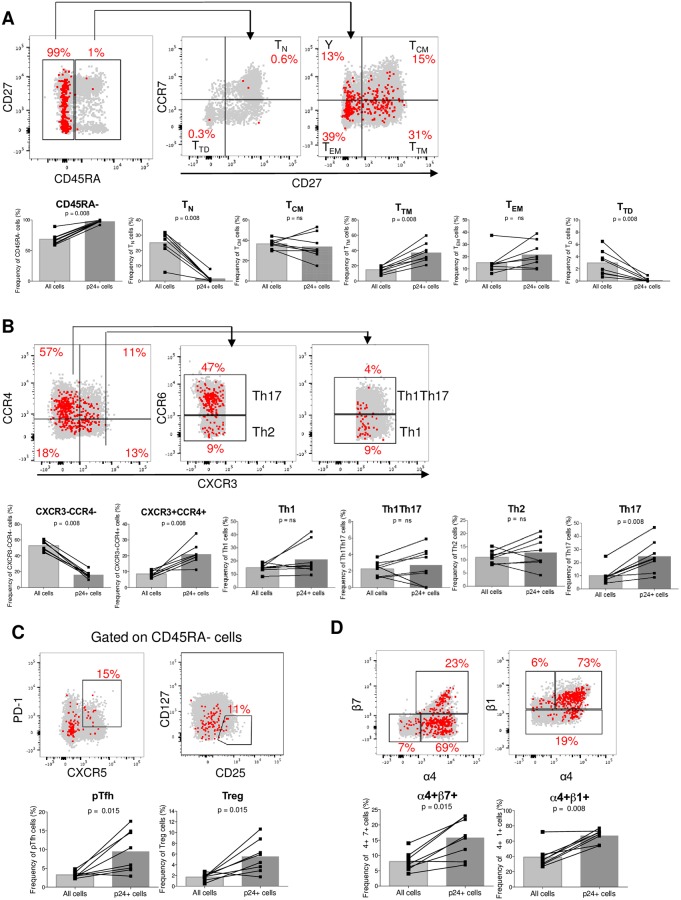
p24-producing cells from untreated individuals are enriched in various cell subsets.Representative dot plots showing the phenotype of p24+ cells (represented as red dots) overlaid onto all cells (in grey) after an 18h-resting. The contribution of a given subset to the pool of all cells and to the pool of infected cells (p24+) are compared in samples from n = 8 untreated individuals (same as in Fig 4). (A) Memory phenotype: TN, TCM, TTM, TEM and TTD cells. (B) CXCR3-CCR4-, CXCR3+CCR4+, Th1, Th2, Th17, and Th1Th17 cells. (C) pTfh and Treg cells. (D) Integrins: α4β7 and α4β1. For statistical analyses, Wilcoxon matched-pairs signed rank test was performed.